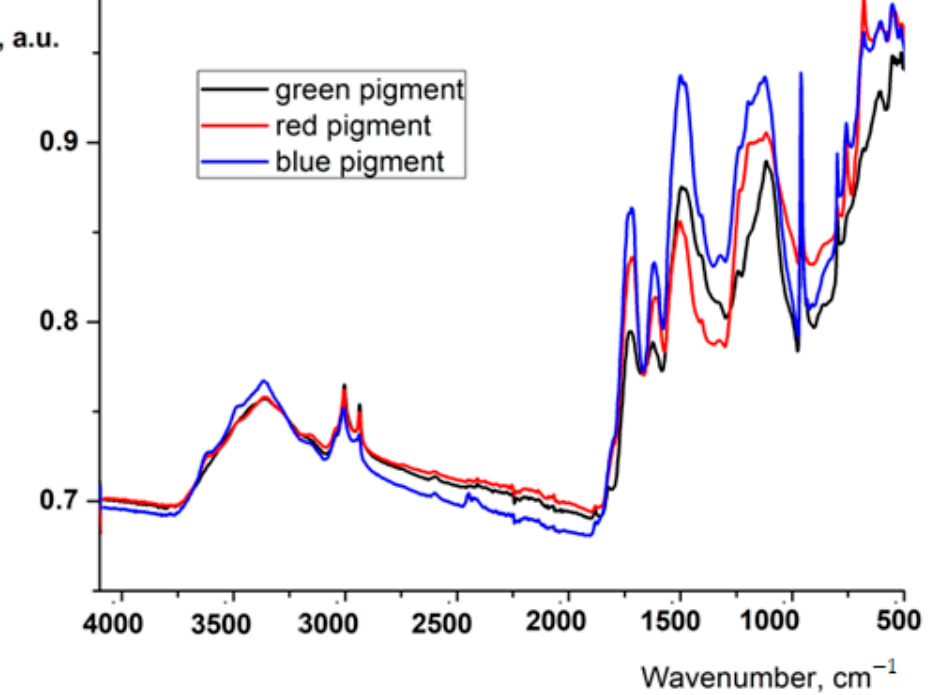
Figure 8. ATR-FTIR spectra of the analyzed samples (green color pigment, blue color pigment, red color pigment) .